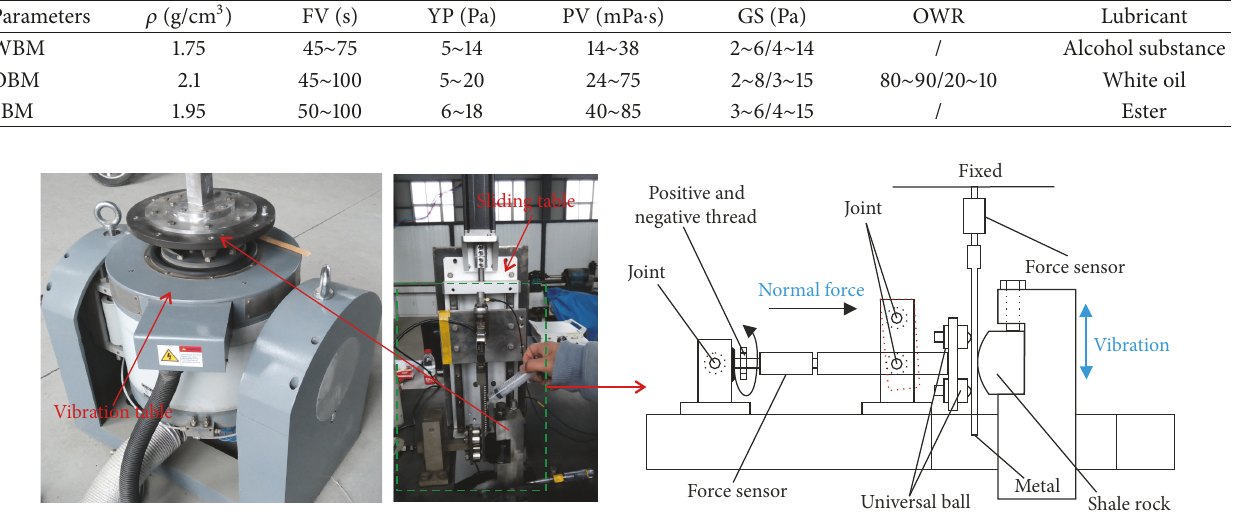
Figure 1: Test rig for axial vibrating-sliding friction coupling.